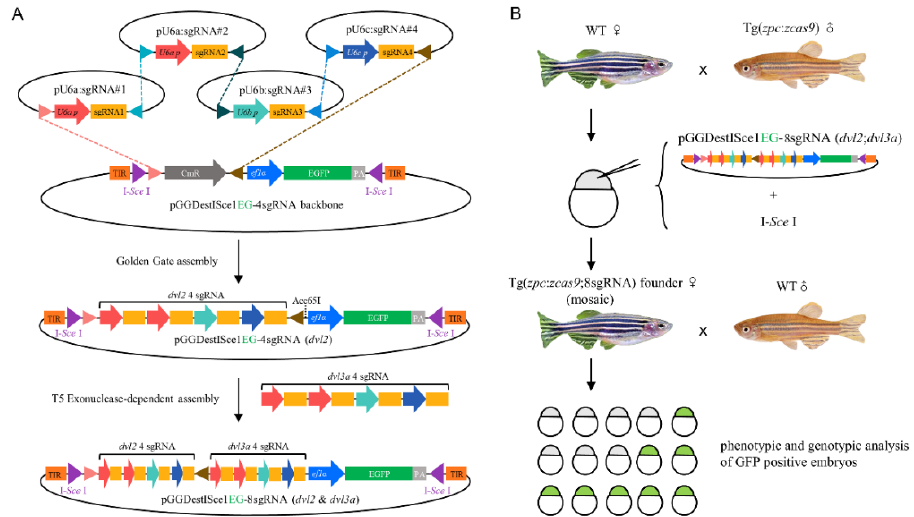
Figure 1. Workflow to generate double maternal mutants for dvl2 and dvl3a genes. ( A ) Two cloning steps to generate transgenic vectors containing eight sgRNA expression cassettes. By Golden Gate ligation, four sgRNA expression cassettes are cloned tandemly into pGGDestISceIEG-4sgRNA backbone, generating pGGDestISceIEG-4sgRNA ( dvl2 ) and pGGDestISceIEG-4sgRNA ( dvl3a ). The four sgRNAs targeting dvl3a were then amplified from the pGGDestISceIEG-4sgRNA ( dvl3a ) plasmid and inserted into the Acc 65I site in pGGDestISceIEG-4sgRNA ( dvl2 ) vector via T5 exonuclease-dependent assembly (TEDA). ( B ) The resultant pGGDestISceIEG-8sgRNA ( dvl2 ; dvl3a ) was coinjected with I- Sce I into embryos spawned by a wild-type female and a Tg( zpc : zcas9 ) homozygous male. The mosaic female with germ-line transmission was outcrossed to produce GFP-positive embryos, which were then genotyped and phenotyped for double maternal mutations.